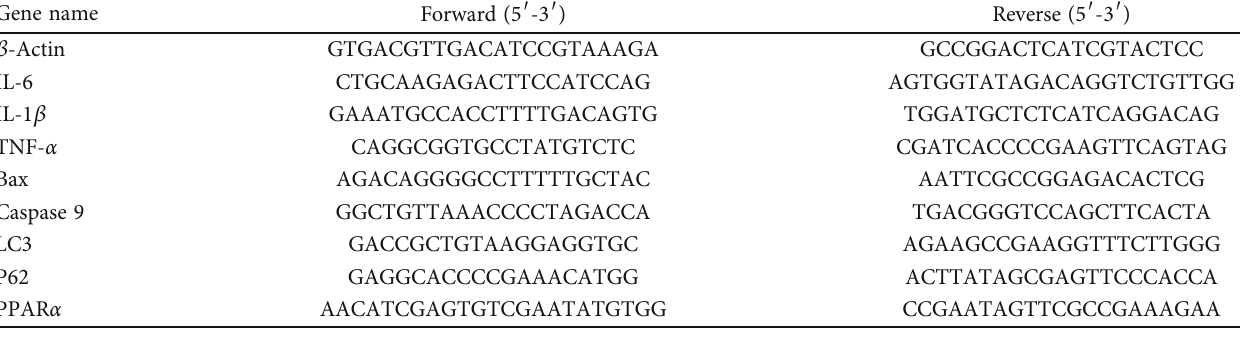
Table 2: Oligonucleotide sequences of primers used for qRT-PCR.